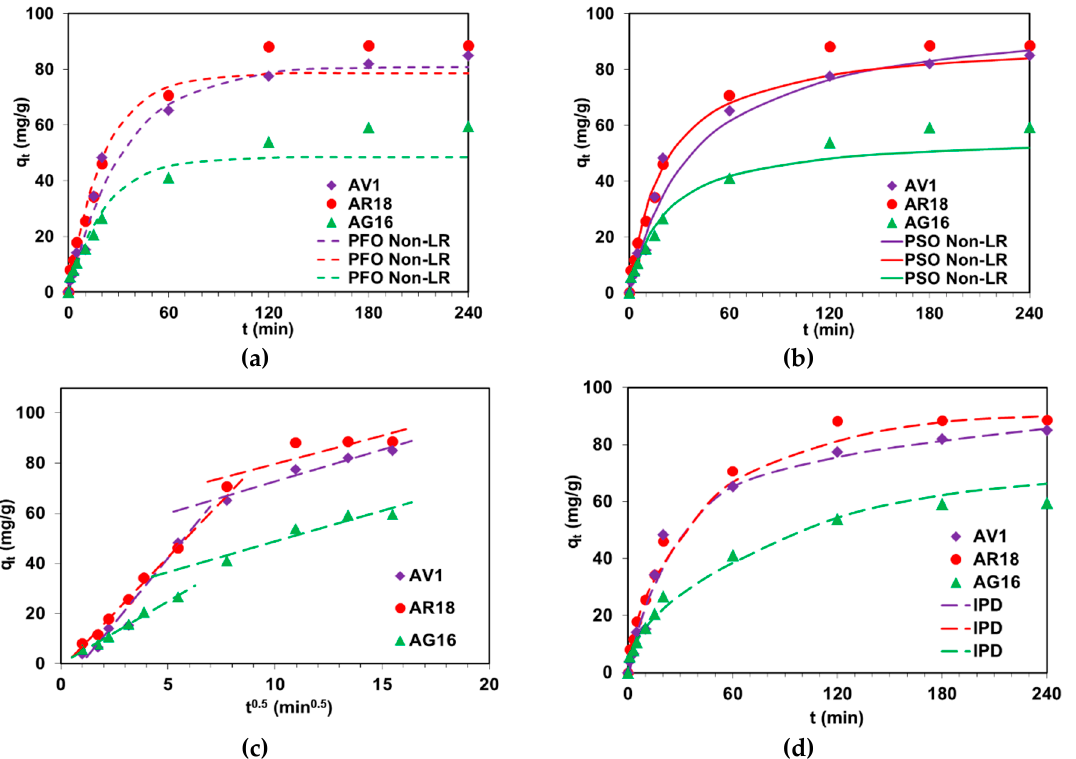
Figure 7. Influence of phase contact time on the acid dye uptake ( C 0 = 100 mg/L) by DVB- co -GMA-TETA with non-linear (Non-LR) fitting of PFO ( a ) and PSO ( b ) kinetic models to experimental data as well as IPD multilinear plot ( c ) and the linear fitting of IPD ( d ) model to experimental data.